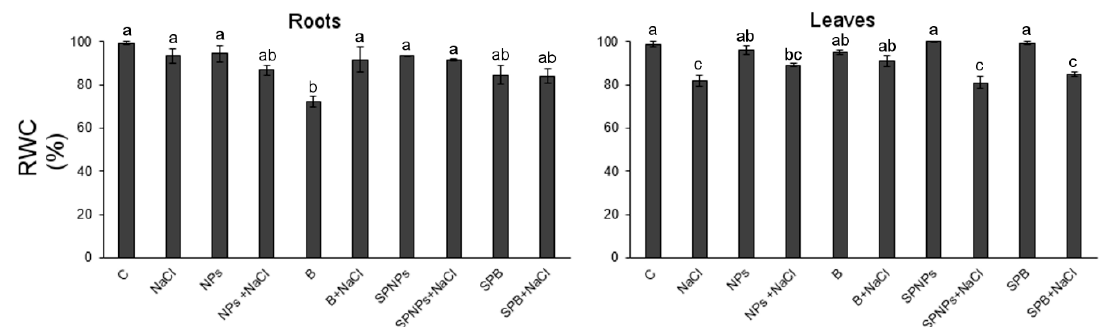
Figure 6. Relative water content (RWC) of roots and leaves of T. turgidum L. ssp. durum cv. Cappelli without priming and salt treatment (C), with salt treatment without priming (NaCl), with ZnO treatment in the root zone (nanoparticles, NPs or bulk form, B), with ZnO priming in the root zone with salt treatment (NPs + NaCl or B + NaCl), with ZnO treatment as a leaf spray (SPNPs or SPB), and with ZnO priming as a leaf spray with salt treatment (SPNPs + NaCl or SPB + NaCl): values are means of at least three replicates ± SE. When ANOVA highlighted significant differences, Tukey’s post hoc test was performed, and different letters indicate significantly different mean values at p < 0.05.